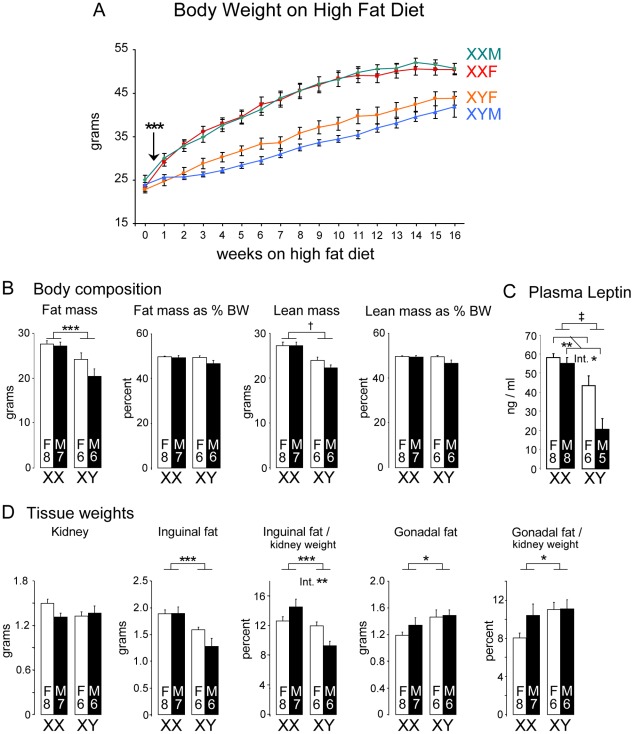
Enhanced weight gain and fat mass in XX compared to XY mice fed a high fat-high carbohydrate diet.(A) FCG mice were fed a high fat-high carbohydrate diet beginning at 4 weeks following GDX (week 0). XX mice first exhibited significantly higher body weight beginning at 3 days on the diet (arrow), and throughout the remainder of the study. (B) Body composition was determined by NMR at 16 weeks of the high fat-high carbohydrate diet. Fat and lean mass are shown as absolute mass and as percent of total body weight (BW). (C) Plasma leptin levels were higher in XX mice than XY mice at the end of the 16 week high fat diet period, and higher in gonadal females than gonadal males. (D) Tissue weights were determined by excision after 16 weeks on the high fat-high carbohydrate diet. Kidney weight did not differ among the four genotypes. Inguinal and gonadal fat pads are shown as absolute weights and normalized to kidney weight. Values shown for all bars represent mean ± SEM for the number of each genotype indicated. *, p<0.05; **, p<0.01; ***, p<0.001; †, p<0.0001; ‡, p<0.000001.